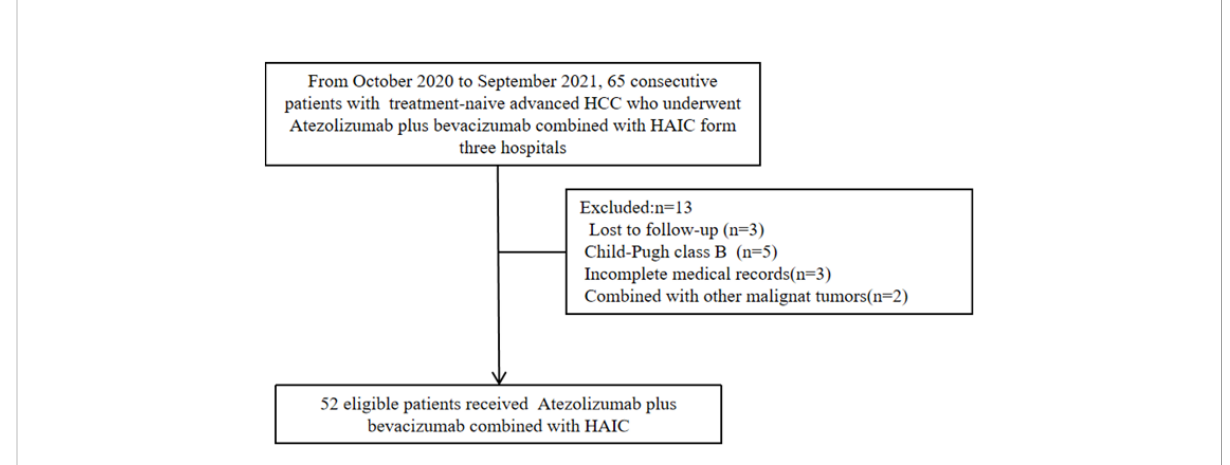
FIGURE 1 Patient fl ow